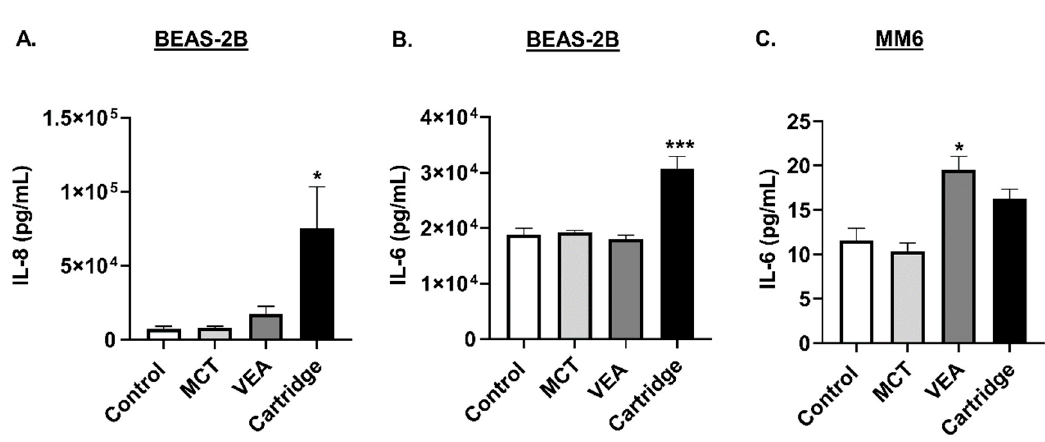
Figure 2. Induction of di ff erential cytotoxicity and inflammatory cytokines, IL-8 and IL-6, responses by counterfeit vape cartridge exposure in lung epithelial cells and monocytes. BEAS-2B cells exposed to medium-chain triglycerides (MCT) oil, vitamin E acetate (50% w / v in MCT), and counterfeit vape cartridges with 2 pu ff s of 70 mL in total 10 min. Twenty-four hours later, cytokines ( A ) IL-8 and ( B ) IL-6 were measured in the conditioned media by ELISA. One-way ANOVA * p < 0.05 and *** p < 0.001 vs. control. MCT and VEA are nonsignificant vs. control ( n = 6 / group). ( C ) Mono-Mac-6 cells were seeded at a density of 5 × 10 5 cells / well in 5% FBS containing media. The following day, cells were treated with 50 µ M vitamin E acetate, 0.25% MCT, and counterfeit vape cartridges at 0.25%. Twenty-four hours post-treatment, IL-6 cytokine level was measured in the conditioned media by ELISA. One-way ANOVA * p < 0.05, ** p < 0.01, and *** p < 0.001 vs. control. p > 0.05 were considered nonsignificant and were not denoted with asterisks ( n = 3–9).